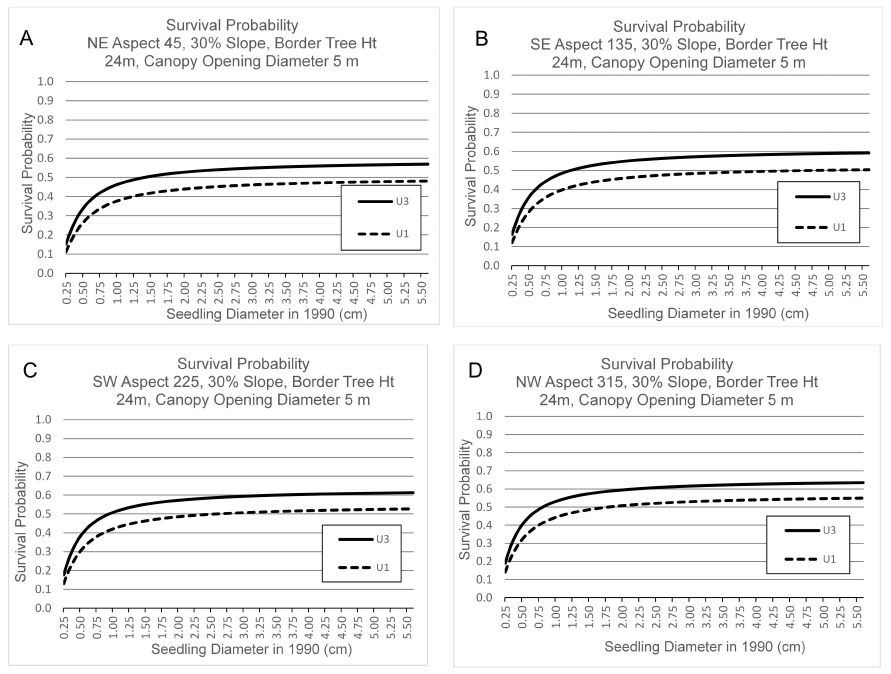
Figure 4. The relationship between seedling diameter, survival probability and understory treatment (U3 is understory treatment with an herbicide applied to cut stems, U1 refers to no understory treatment). ( A )–( D ) With 30% slope, canopy border tree height of 24 m, and canopy opening diameter of 5 m.